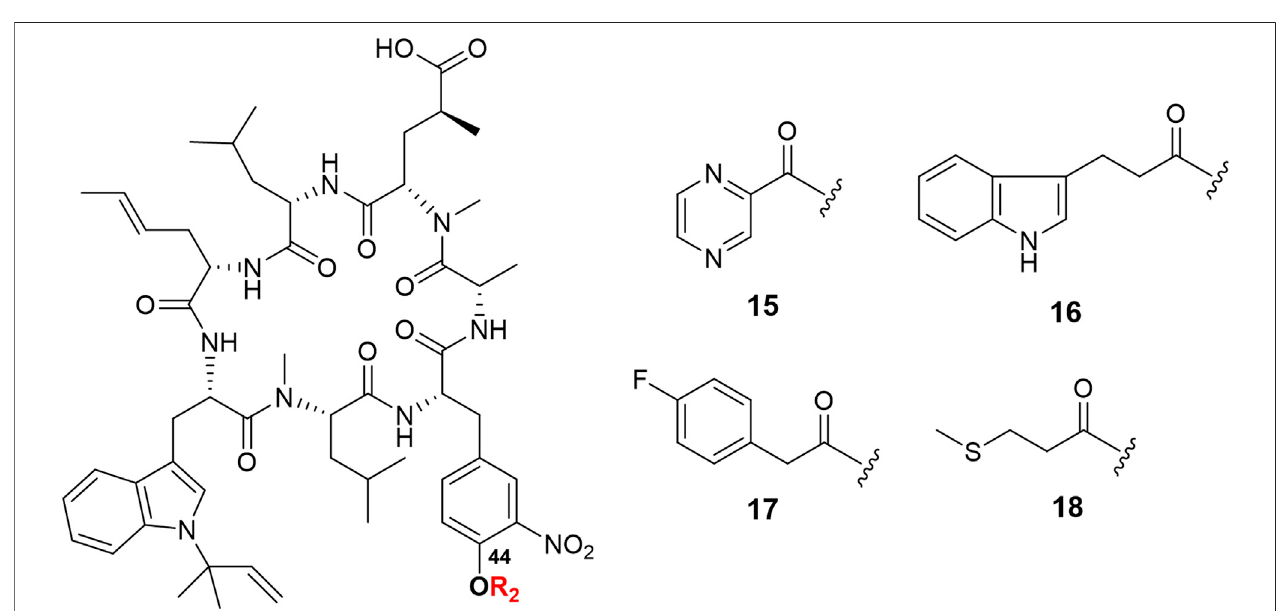
FIGURE 3 | Structures of ilamycin NJLs modi fi ed at C-44 (compounds 15 – 18 ).